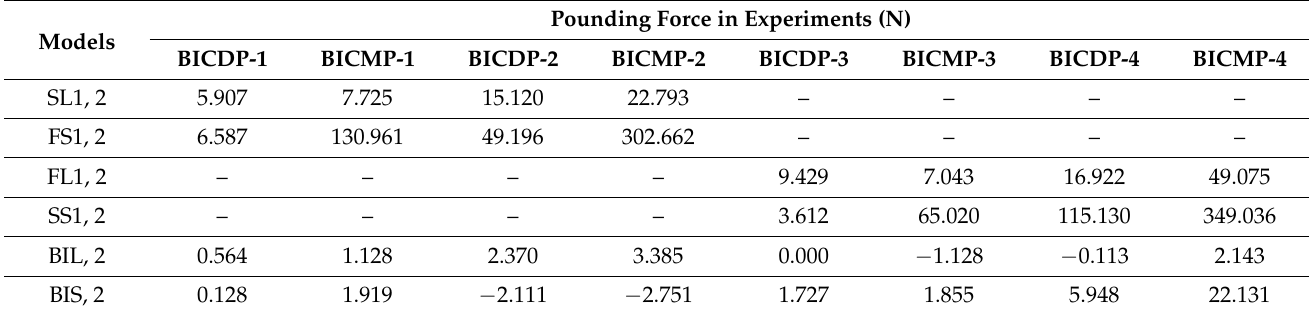
Table 12. The pounding effect between different frequency base-isolated models.